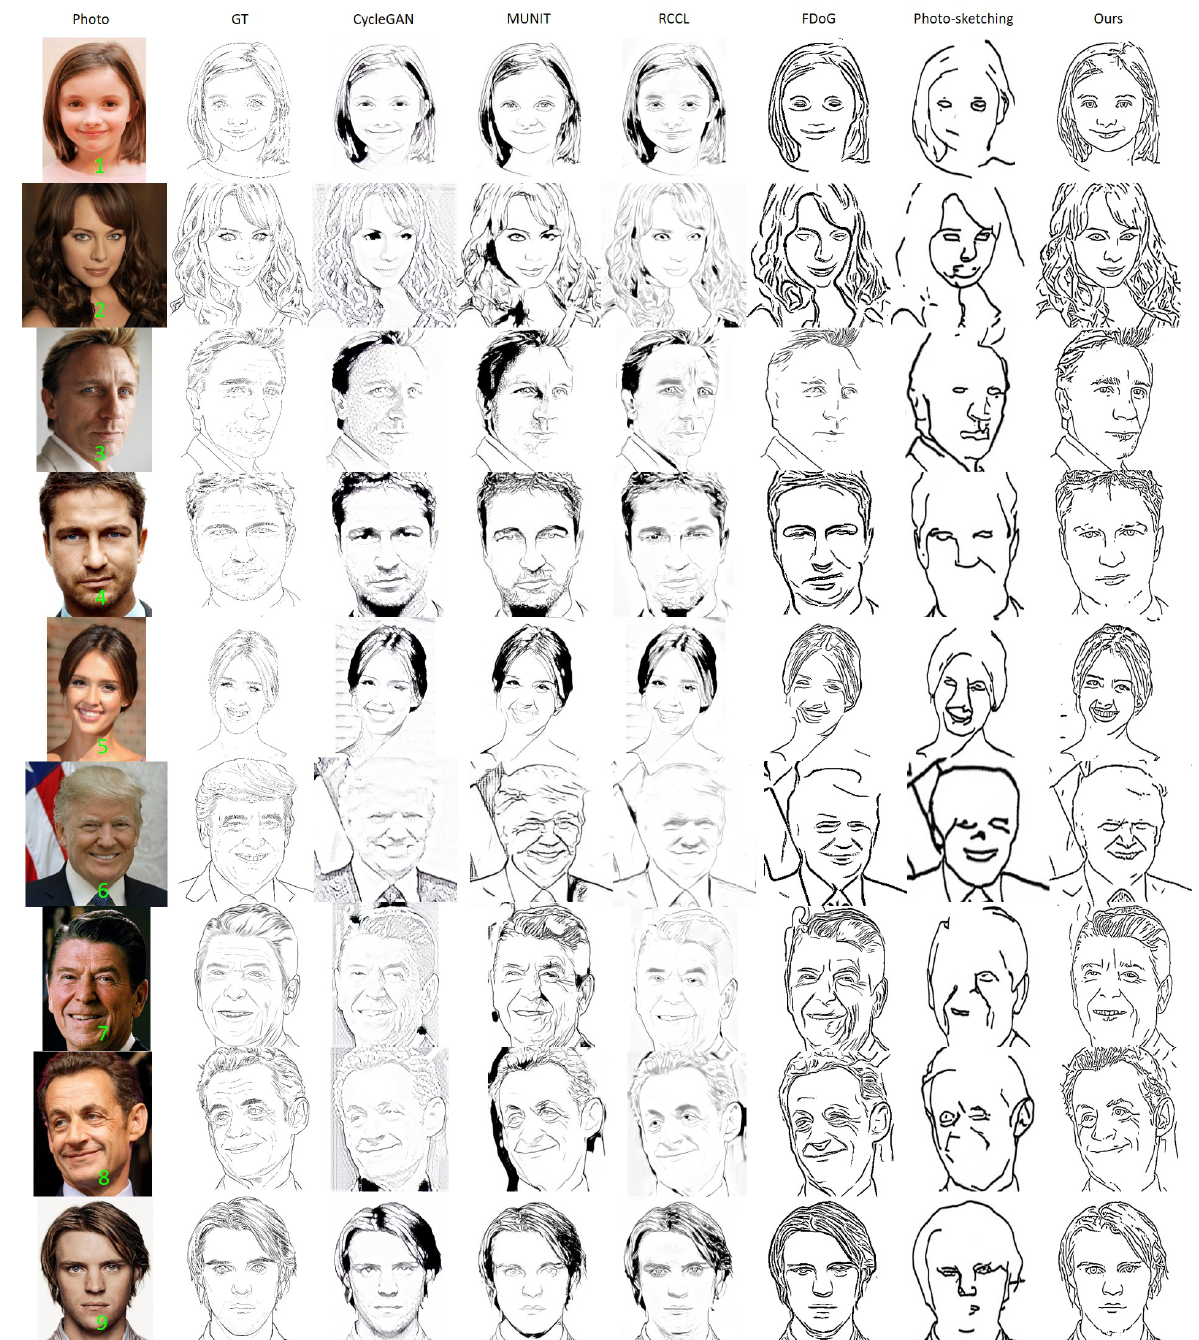
Figure 7. Comparison with existing studies: GT is created by professional artists, CycleGAN [5], MUNIT [7], RCCL [20], FDoG [3], and Photo-sketching [11] are compared. The TP (true positive), FP (false positive), and FN (false negative) rates are estimated from the generated sketch image I s and GT image I G . TP is defined as the number of pixels which belong to sketch lines in both the generated sketch image and the GT image; FP is the number of pixels which belong to sketch lines in the generated image, but not in the GT image; and FN is the number of pixels which do not belong to sketch lines in the generated image, but belong to sketch lines in the GT image. The values of the pixels in the line-based sketch images are either black (0) for the sketch lines or white (1) for the empty regions. Therefore, the TP , FP , and FN are defined as